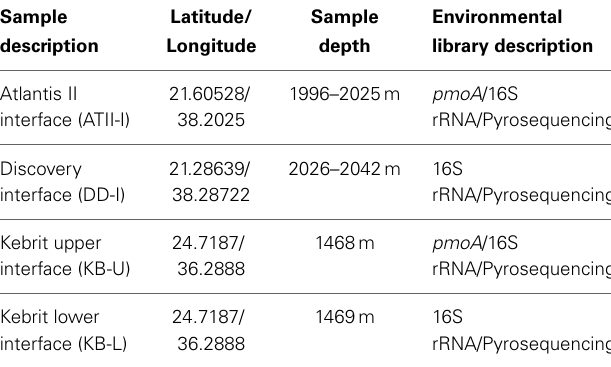
Table 1 | Description of